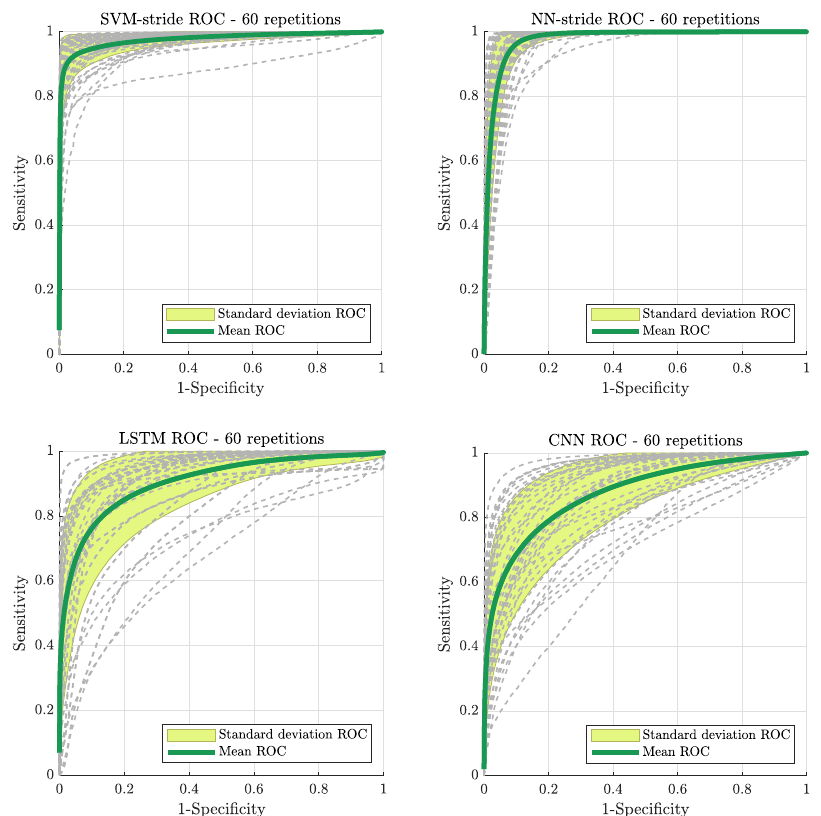
Figure 4. The four charts illustrate the receiver operating characteristic (ROC) curves computed for every model and averaged over 60 cross-validation repetitions (mean curve indicated with thick green line). The curves represent the pairs of sensitivity and specificity of the classifier when trialing all possible prediction thresholds. An ideal classifier would correspond to a pair of maximum specificity and maximum sensitivity of 1, hence a clustering towards the upper left corner is